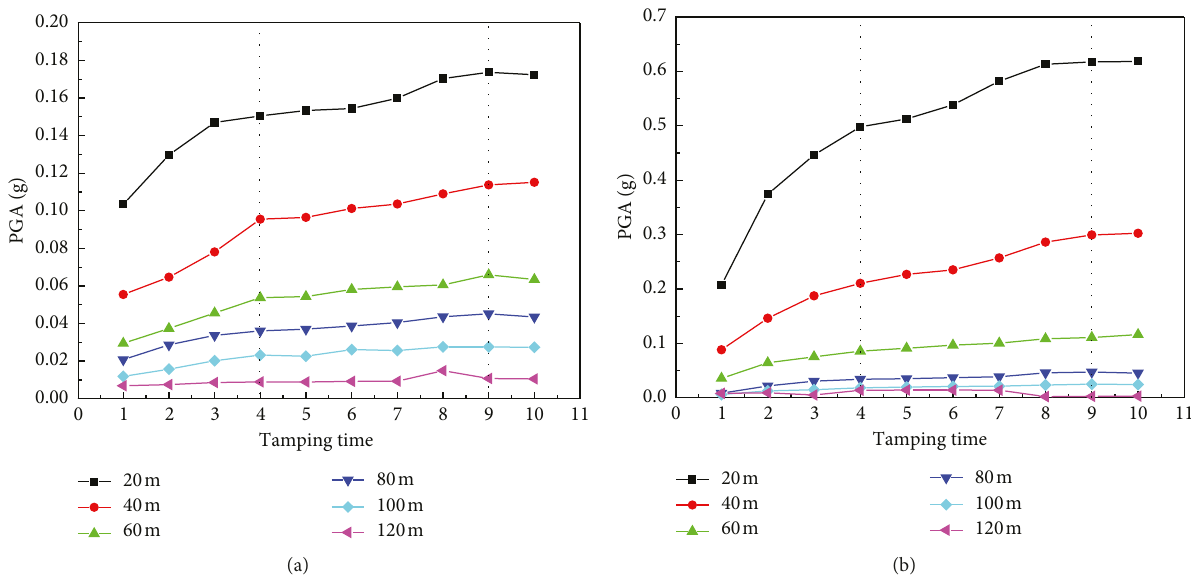
Figure 8: Relations between PGA and tamping time at different measured distances. (a) In radial direction. (b) In vertical direction.